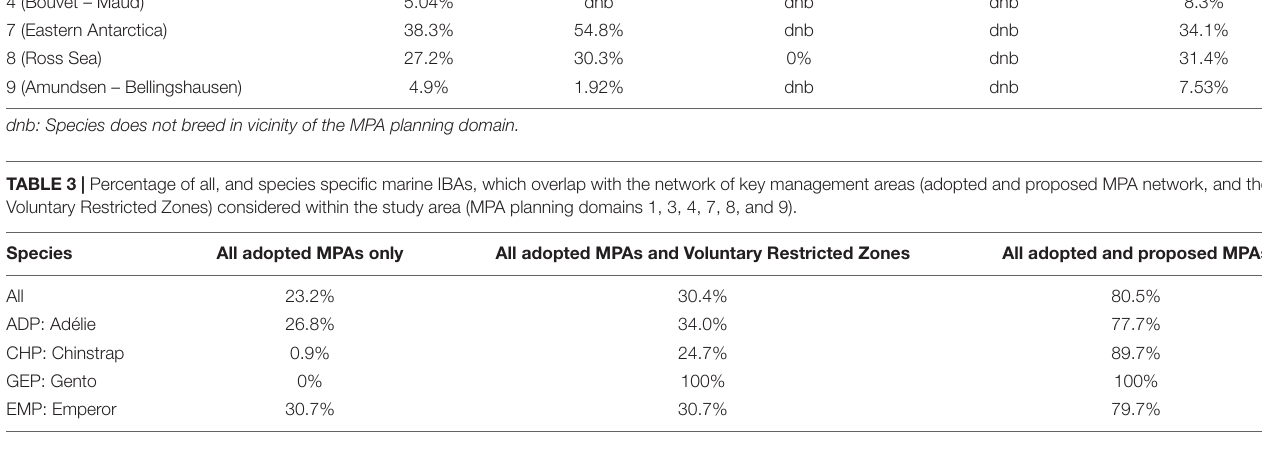
TABLE 4 | Percentage of marine IBAs in each of the specific MPAs within the study area (see Figure 2 for